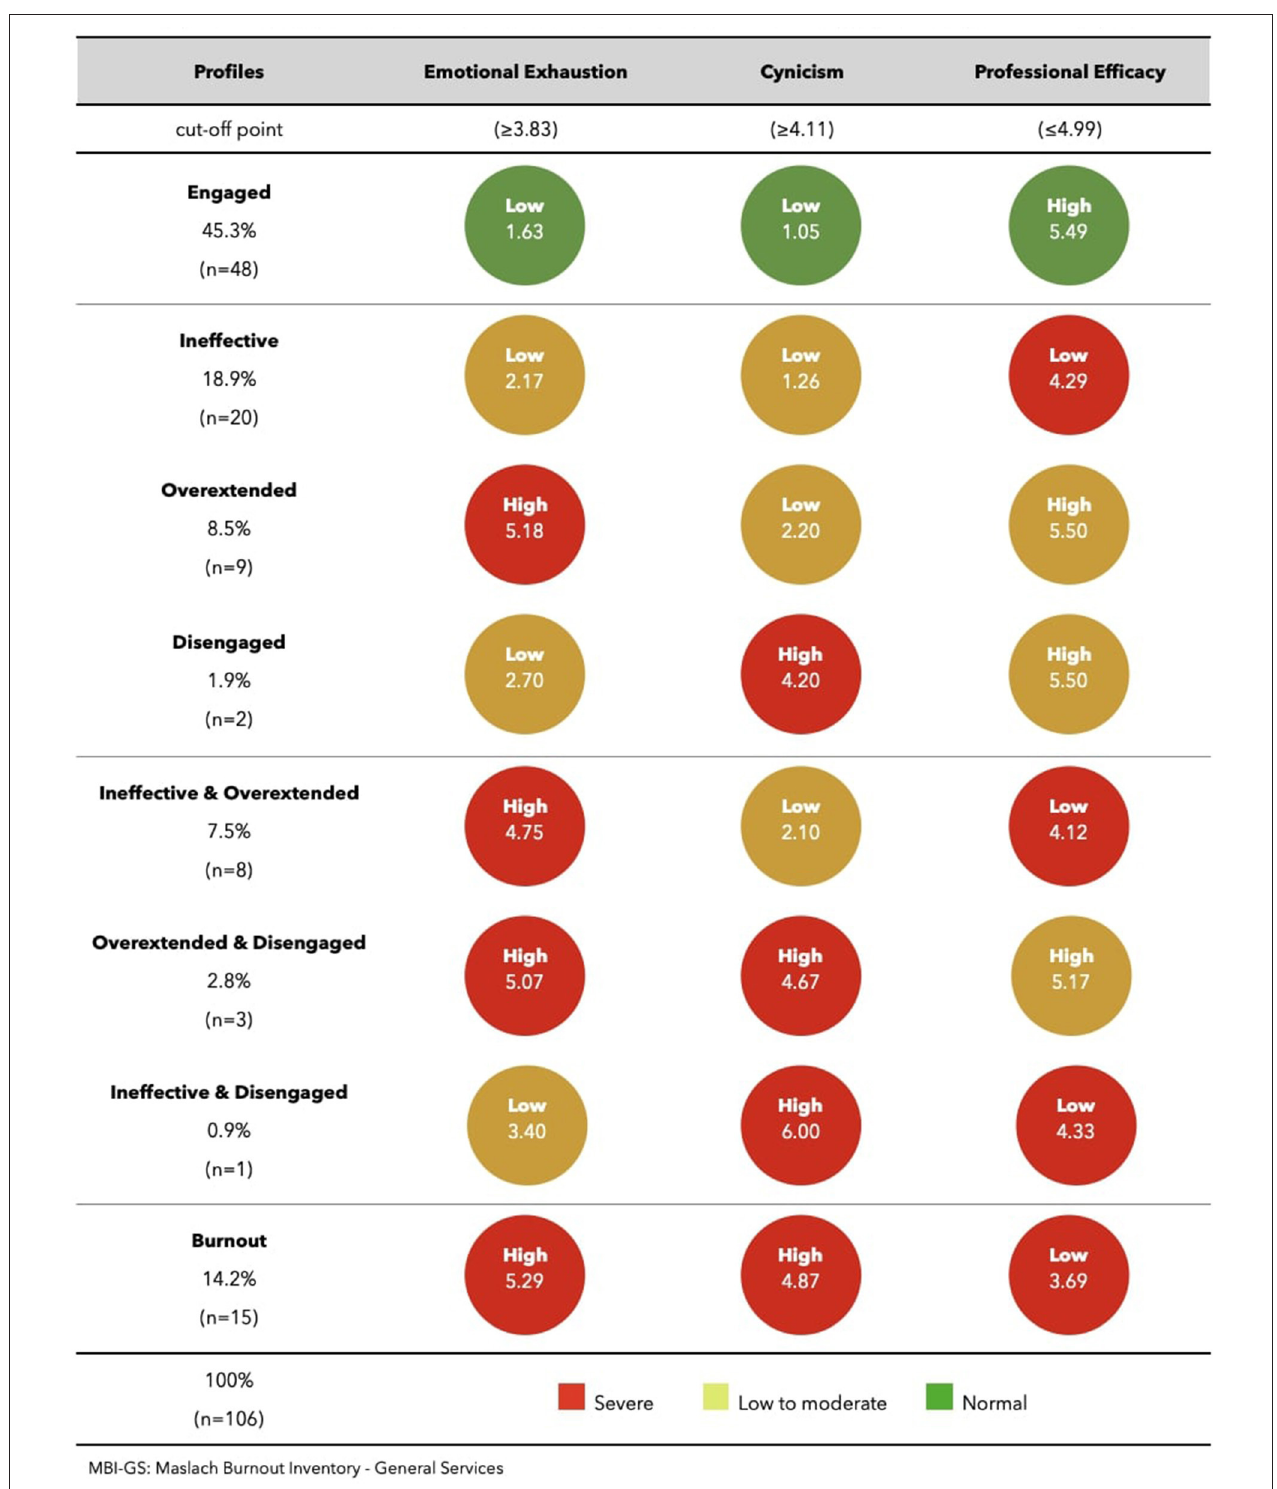
FIGURE 2 | Pattern of MBI-GS subscales across profiles: pharmacists with non-direct patient care activity.